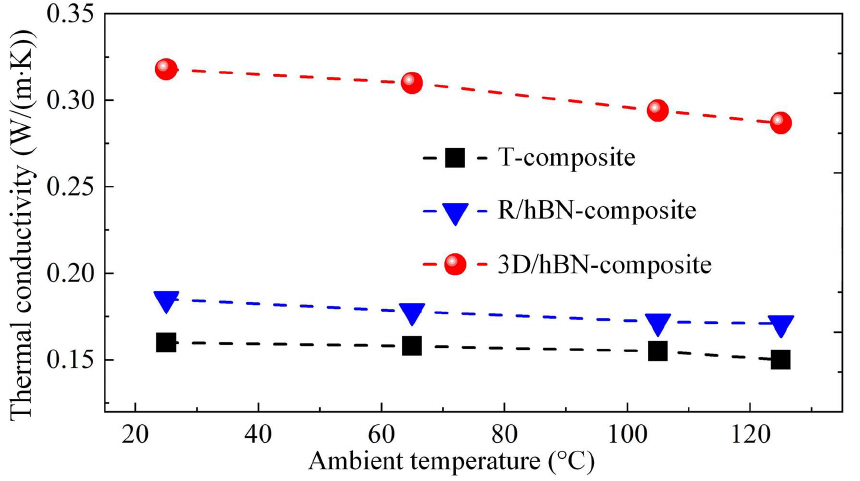
Figure 5. Measured thermal conductivities of the T-composite, R/hBN-composite, and 3D/hBN- composite under different ambient temperatures.